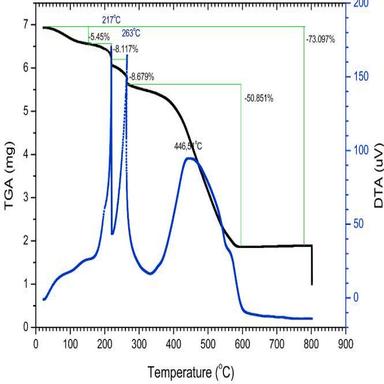
Thermal gravimetric analysis of MnO2/MWCNTs sorbent.